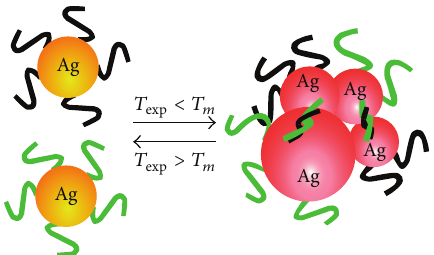
Figure 10: AgNPs-oligonucleotide conjugates (adapted from